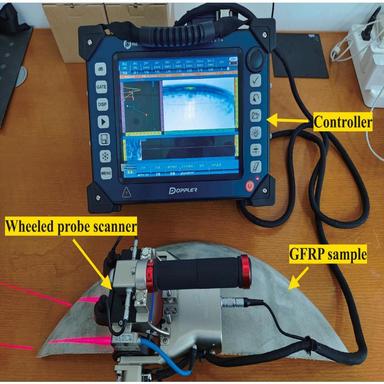
The phased array ultrasonic testing system.